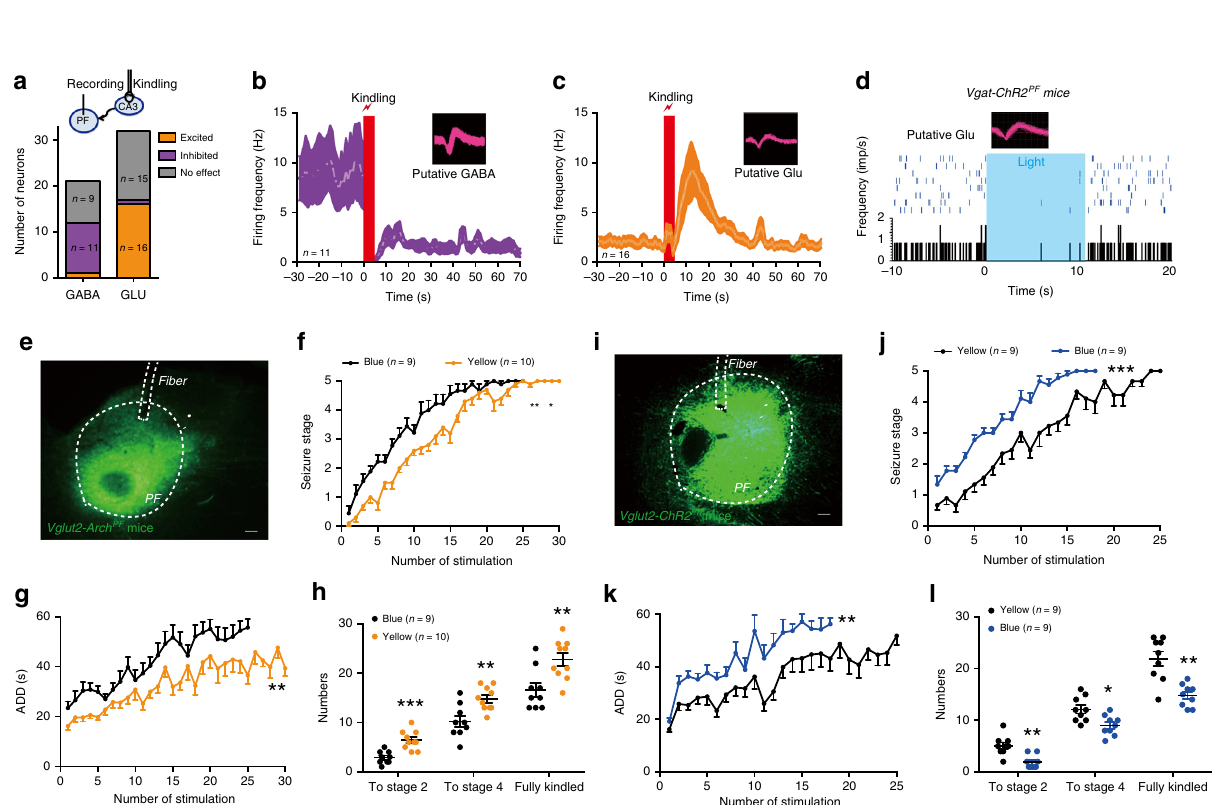
Fig. 7 PF glutamatergic neurons bidirectionally modulate kindling progression in hippocampal kindling model. a Above, scheme of experiment for kindling stimulation in the CA3 and in vivo single-unit recordings in the PF. Below, statistic of responses of recorded PF GABAergic and glutamatergic neurons during hippocampal kindling-induced seizures from three wild-type mice. b , c Average fi ring rates of responsive PF GABAergic ( b ) and glutamatergic neurons ( c ) during hippocampal kindling-induced seizures. d Representative peri-event raster histogram showing the fi ring of the PF glutamatergic neuron in response to blue-light stimulation in one Vgat-ChR2 PF mouse. e Representative image of the PF from a Vglut2-Arch PF mouse. Scale bar, 100 μ m. f – h Effects of optogenetic inhibition of PF glutamatergic neurons on the development of seizure stage ( f ), afterdischarge duration (ADD, g ), and number of stimulations needed to each seizure stage ( h ) in the hippocampal kindling model. Align-and-rank data for a nonparametric ANOVA was used in f , general linear model with repeated measures was used in g , and Mann – Whitney U -test was used in h ; ** P < 0.01, *** P < 0.001 compared with blue-light control. i Representative image of the PF from a Vglut2-ChR2 PF mouse. Scale bar, 100 μ m. j – l Effects of optogenetic activation of PF glutamatergic neurons on the development of seizure stage ( j ), ADD ( k ), and number of stimulations needed to each seizure stage ( l ) in the hippocampal kindling model. Align-and-rank data for a nonparametric ANOVA was used in j , general linear model with repeated measures was used in k , and Mann – Whitney U -test was used in l ; * P < 0.05, ** P < 0.01, *** P < 0.001 compared with yellow-light control. The number of mice used in each group is indicated in the fi gure. All the data are presented as mean ± SEM. Source data are provided as a Source Data fi GABAergic neurons signi fi cantly increased after a GS compared activation of SNr GABAergic neurons, including PV neurons, with naive controls 46 , it is still unclear how this hyperactivated promoted kindling progression, whereas inhibition of these reaction of SNr GABAergic neurons in fl uences seizure activities neurons alleviated the severity of epileptic seizures in the hip- of TLE. Using optogenetics, we provided direct evidence that pocampal kindling model. Furthermore, chemogenetic inhibition